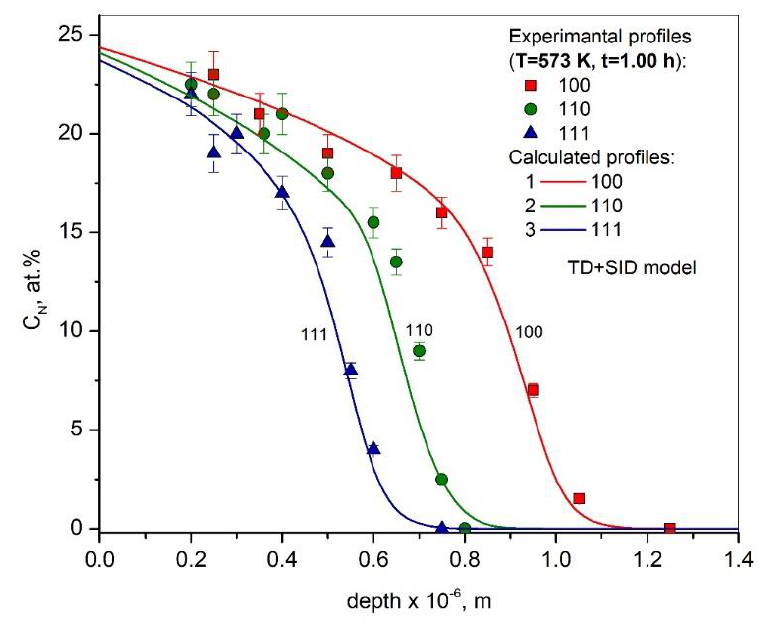
Figure 4. Calculated (lines) and experimental (points) (data from [19]) depth profiles of nitrogen. Nitriding temperature 574 K.